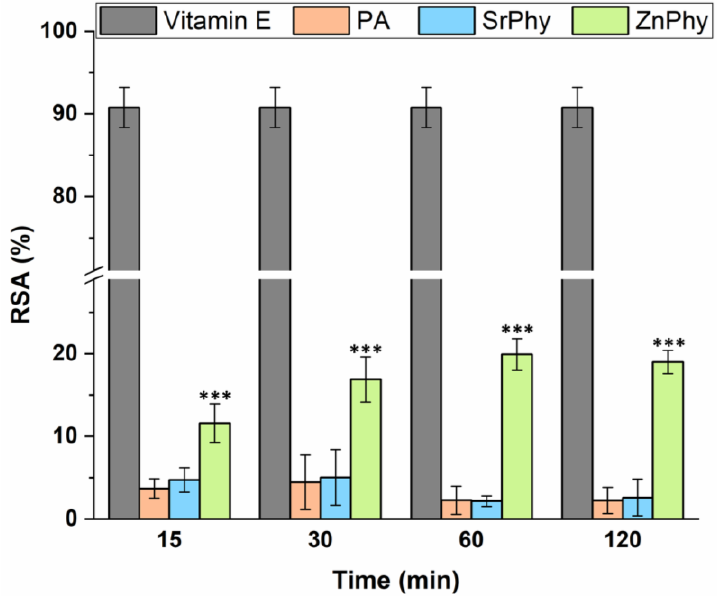
Figure 1. Radical scavenger activities of phytate compounds at 30 µ g/mL that were obtained after 15, 30, 60 and 120 min of incubation with a DPPH solution. Vitamin E was taken as the positive control to assess the maximum RSA achieved. The results are represented as the mean RSA value (%) ± SD ( n = 8), and were statistically evaluated using an ANOVA (*** p < 0.001, Tukey’s test).